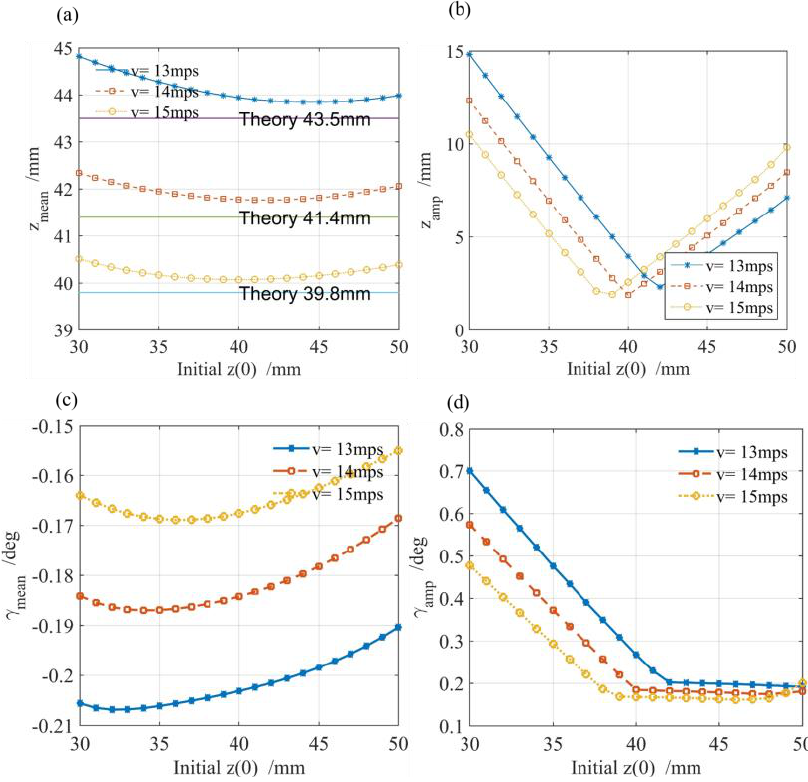
= 300 kAt: ( a ) z mean ; ( b ) z amp ( c ) γ mean ; ( d ) γ amp Figure 12. Simulation results when . Figure 12. Simulation results when MMF